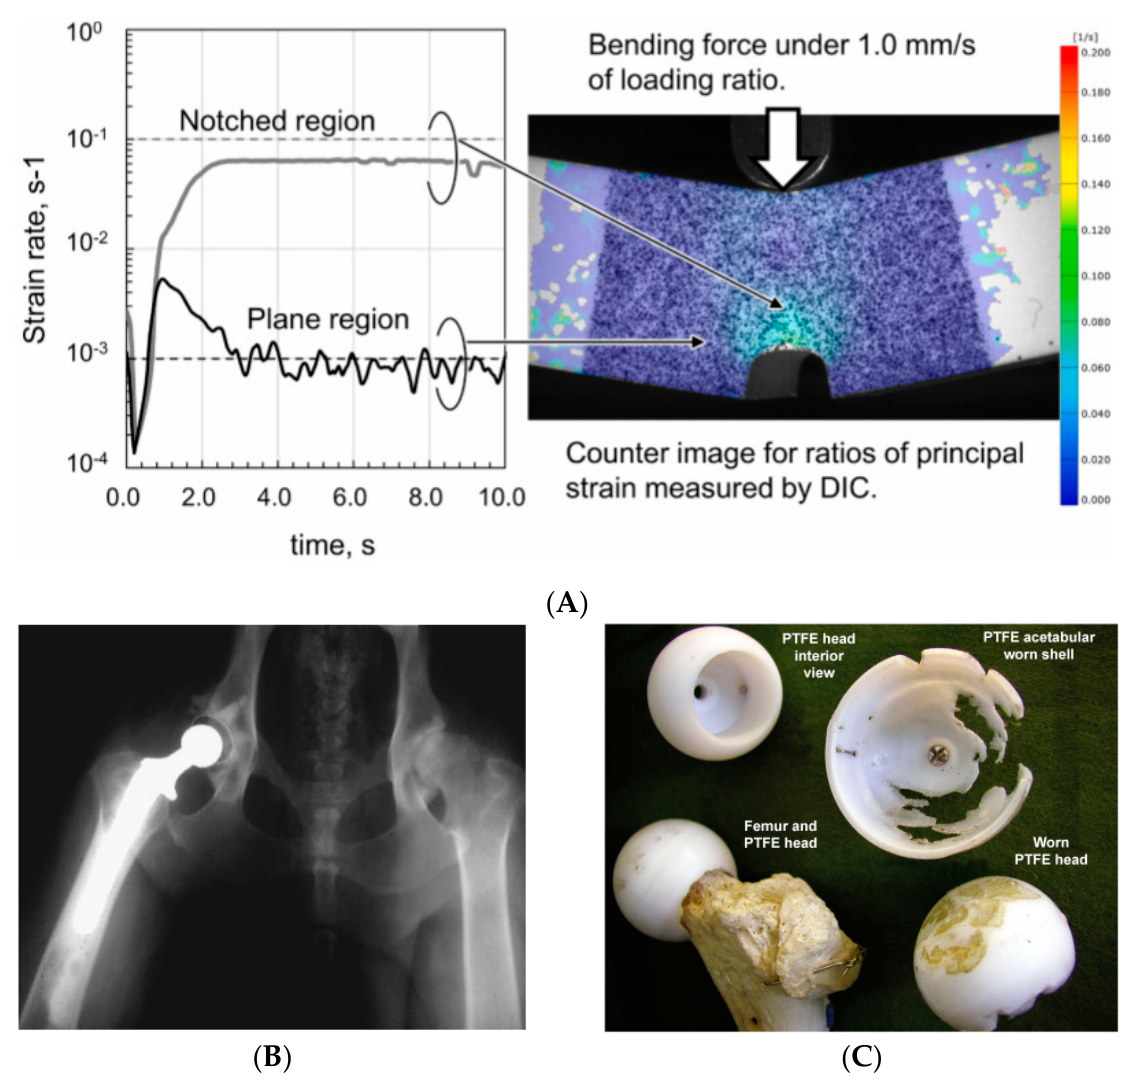
Figure 2. ( A ) Bending test results of PTFE under quasi-static loading [18], ( B ) hip joint cup and ( C ) biological implants showing PTFE components [22].